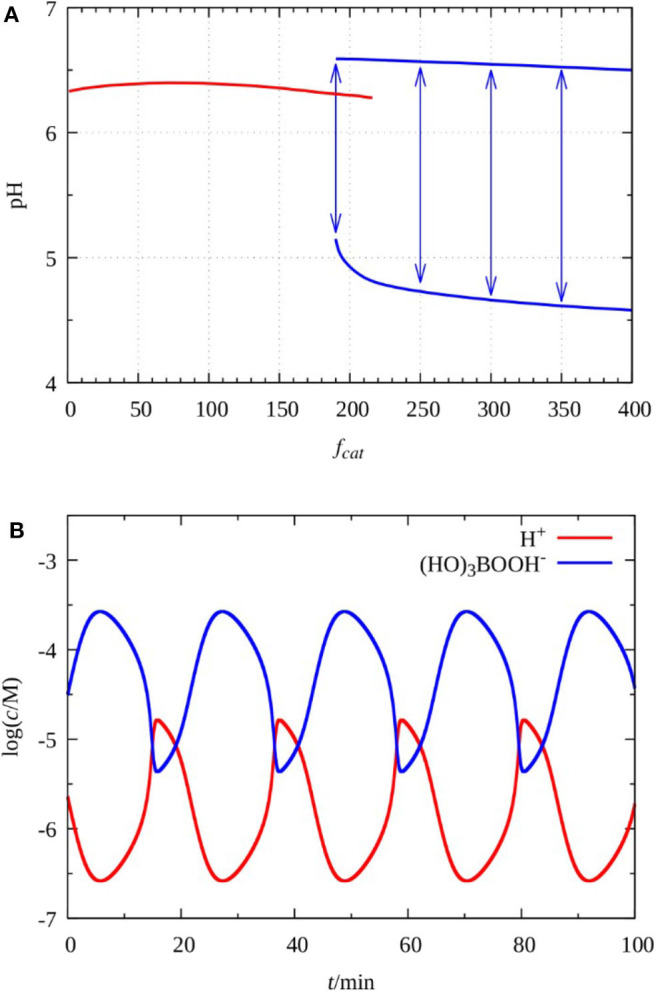
Simulated bifurcations diagram as a function of parameter fcat. The arrows indicates the amplitude of oscillations (A) and oscillations in the concentration of H+ and (HO)3B(OOH)− at fcat= 220 (B). The parameters of the simulations k0 = 0.002 s−1, [S2O3 2−]0 = 0.01 M, [(HO)3B(OOH)−]0 = 0.062 M, [Cu2+]T = 1.5 × 10−5 M, [H+]0 = 0.066 M.